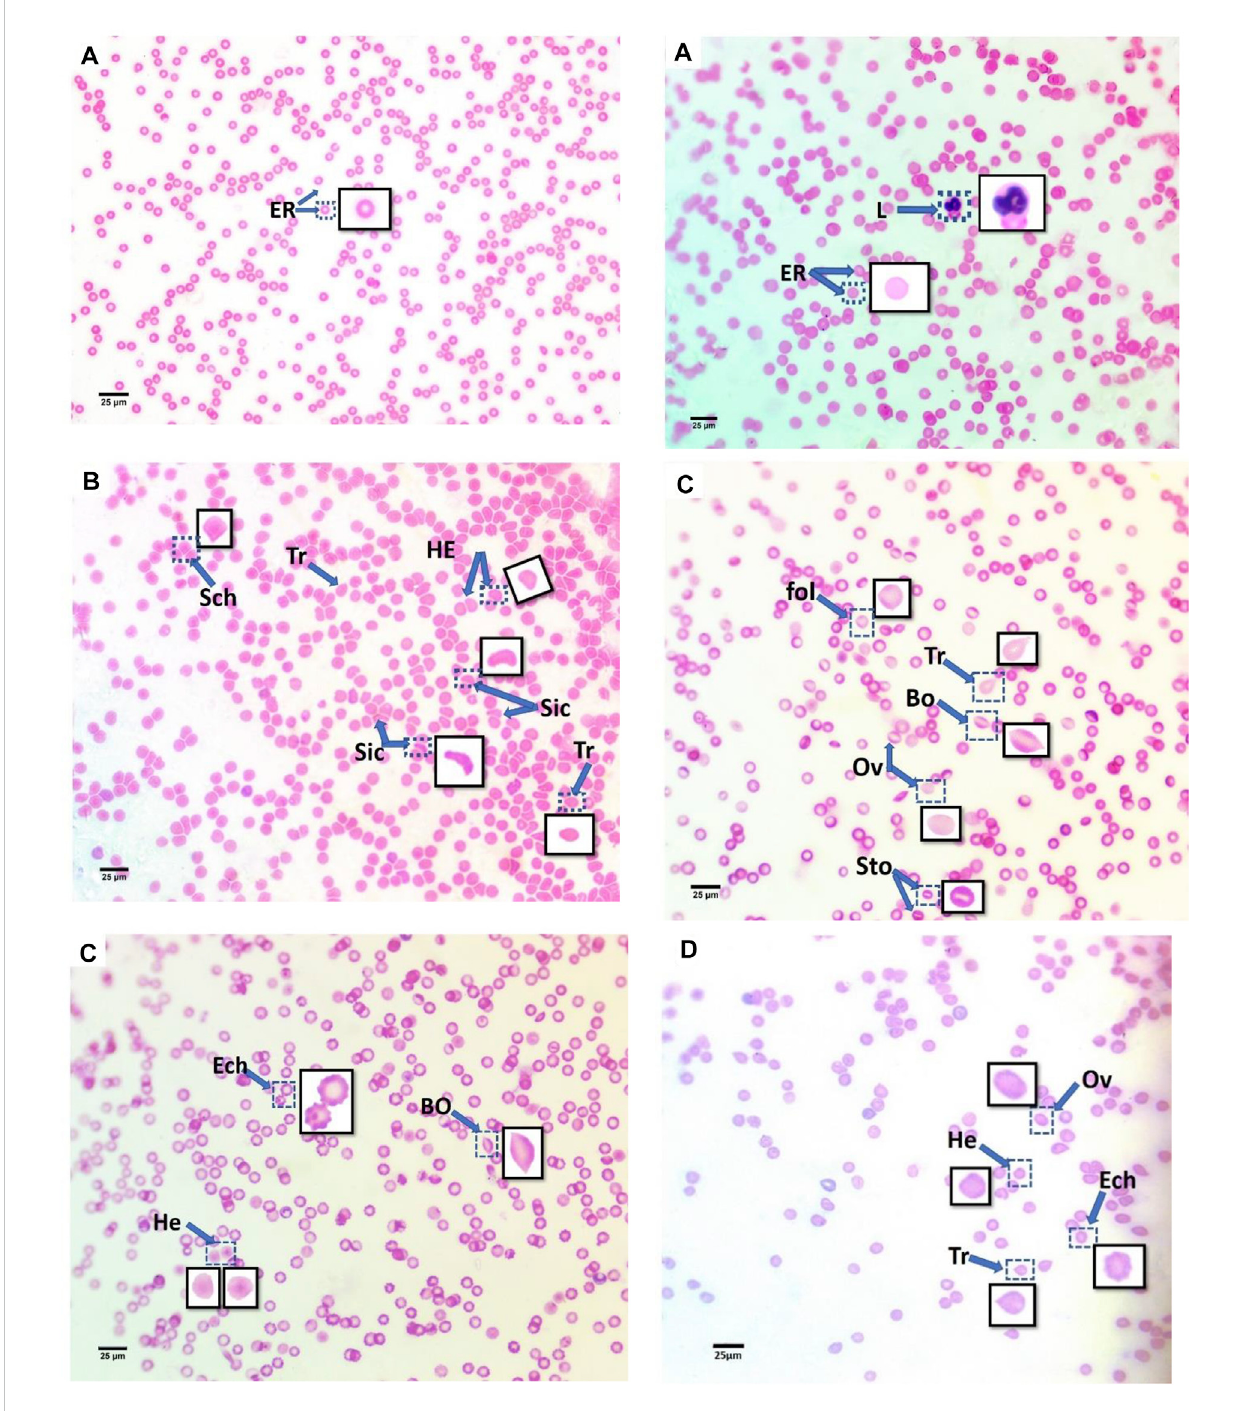
Bloodsmearsoftreatmentmicegroupswithpolyethylenemicroplastics: (A) control, (B) 6 μ g/mlMPs, (C) 60 μ g/mlMPs,and (D) 600 μ g/mlMPs.Er: erythrocytes; L: leucocytes; Tr: teardrop-like cells; HE: helmet cell; Sto: stomatocytes; Sic: sickle cells; Sch: schistocytes; fol: folded cells; Bo: boat- shaped cell; Ov: ovalocytes; and Ech: echinocytes (H&E